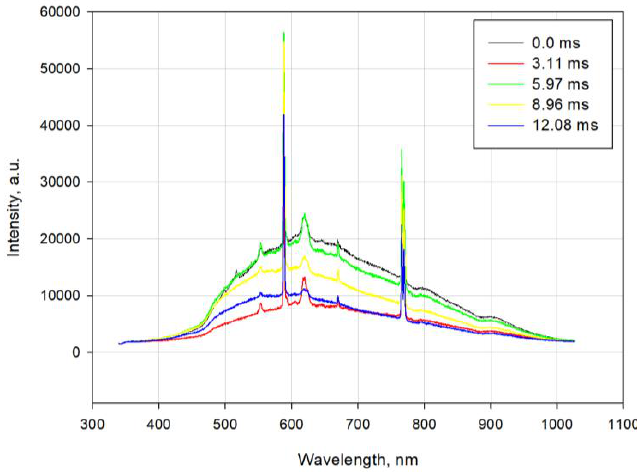
Figure 5. Spectrometer-collected exemplary light-intensity spectra for the tested A3-25 explosive mixture.